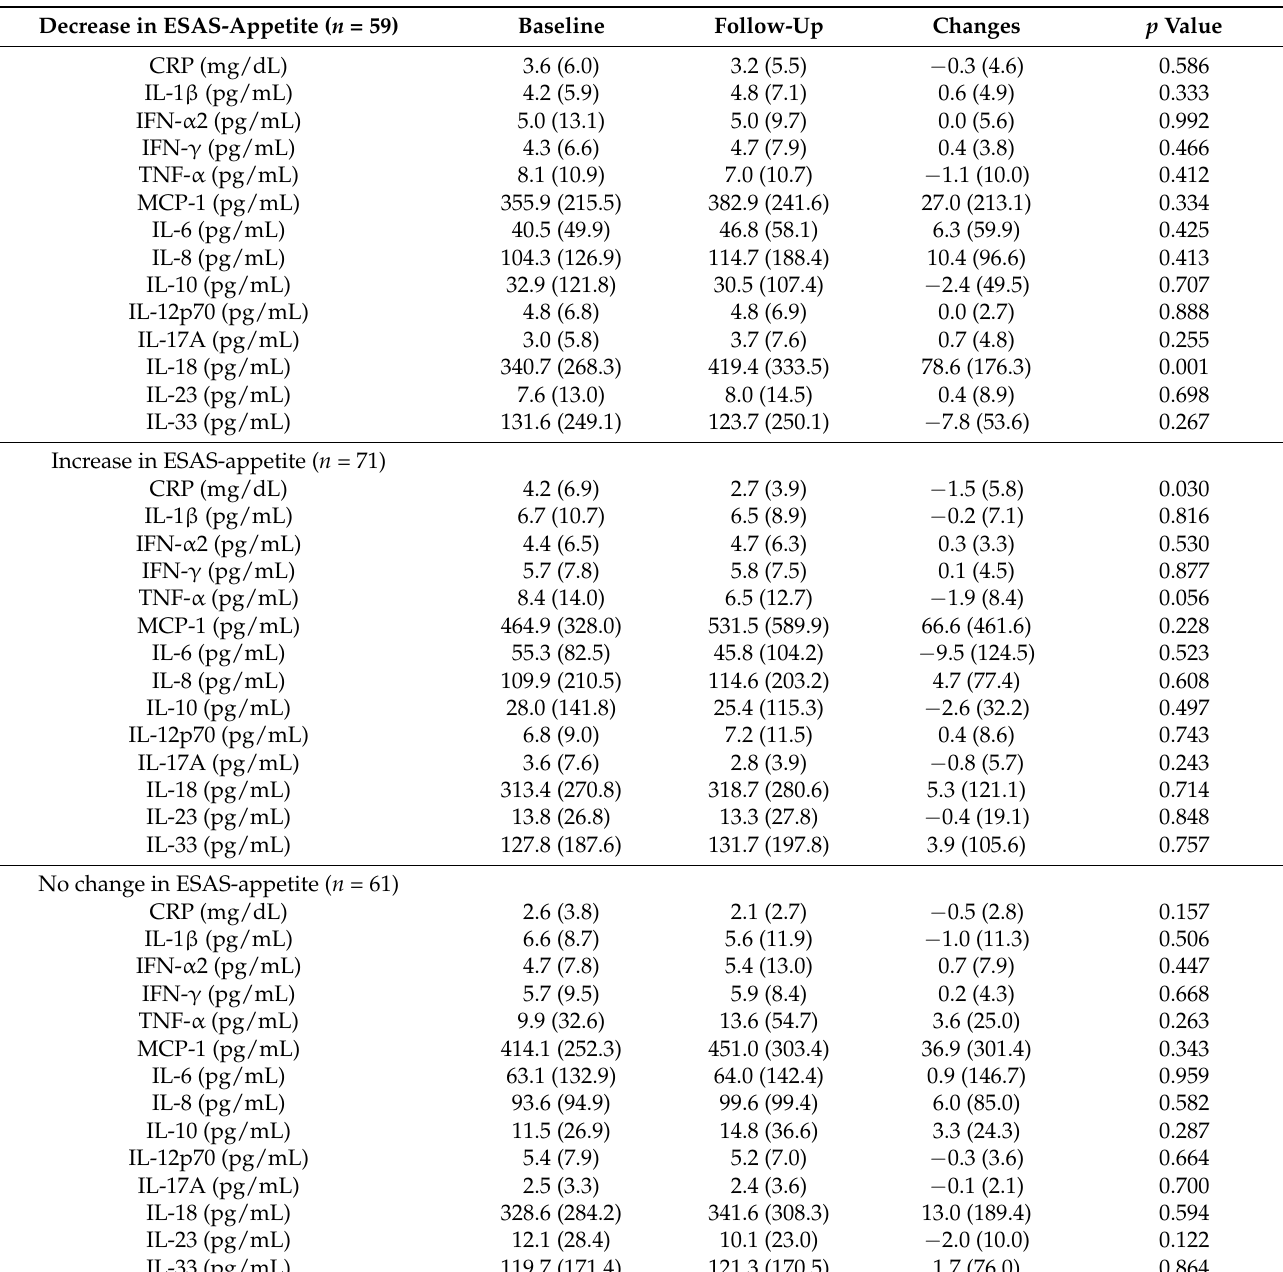
Table 2. Changes in CRP and cytokines from baseline to follow-up stratified by ESAS-appetite status. Decrease in ESAS-Appetite ( n =